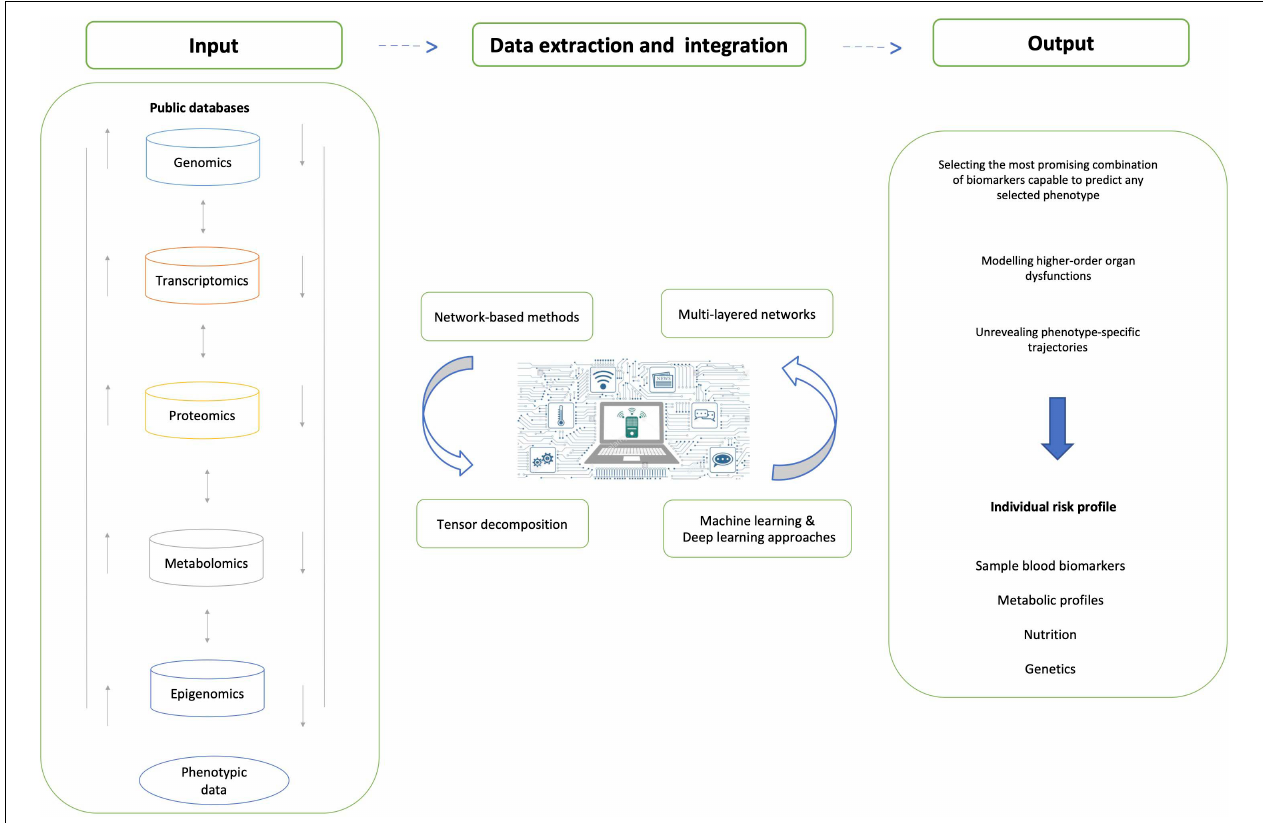
FIGURE 2 | Data integration in aging research. A schematic representation of the process of data integration from public databases and other sources in aging and age-related diseases. The main data sources are represented in the “input” panel, and we represent the key methods described in the manuscript under “data extraction and integration.” We have represented the expected answers in the output, in terms of risk profiles and predictive tools for population stratification and